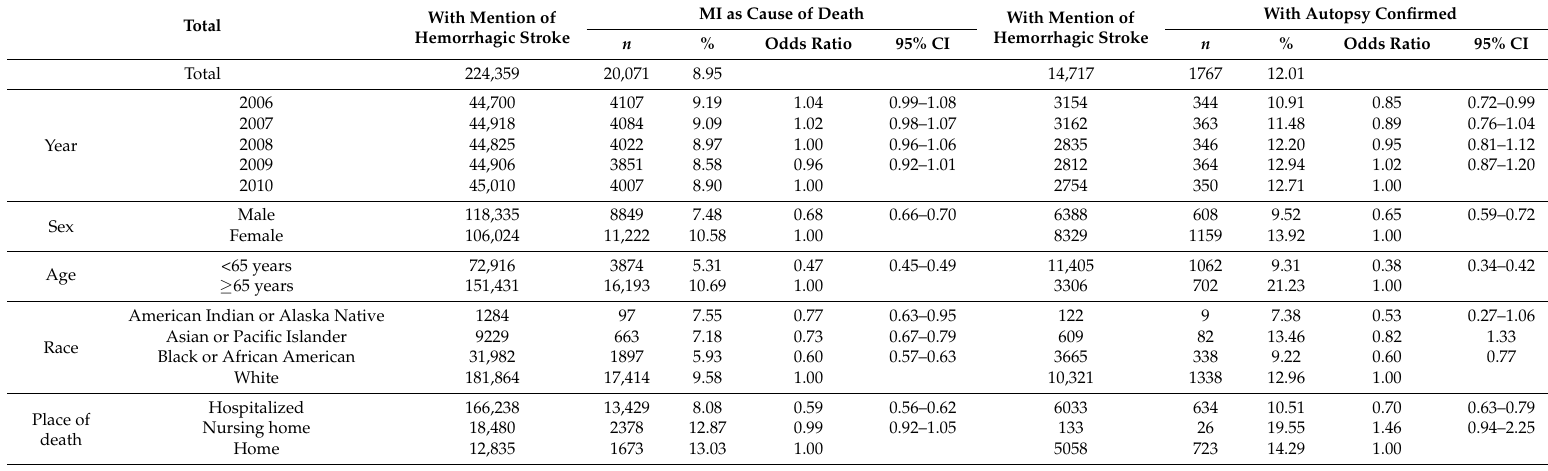
Table 1. The incidence and odds ratio of reporting myocardial infarction (MI) as a cause of death on death certificates with mention of hemorrhagic stroke.